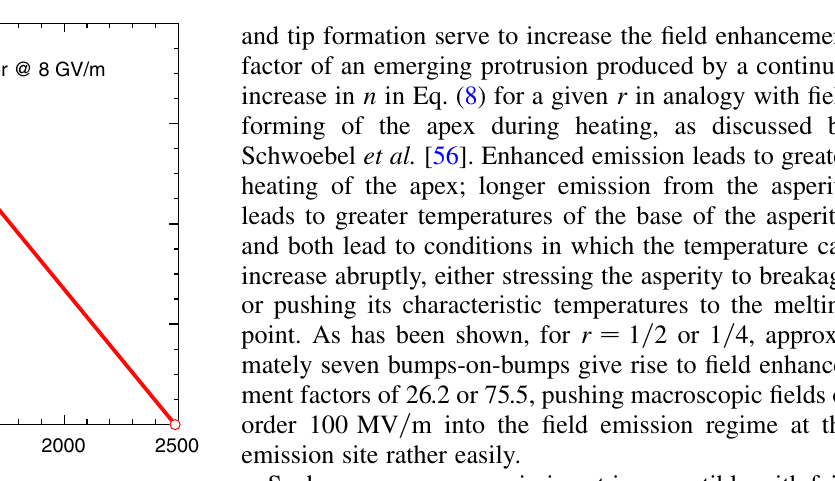
(cid:2) T . As the base o base